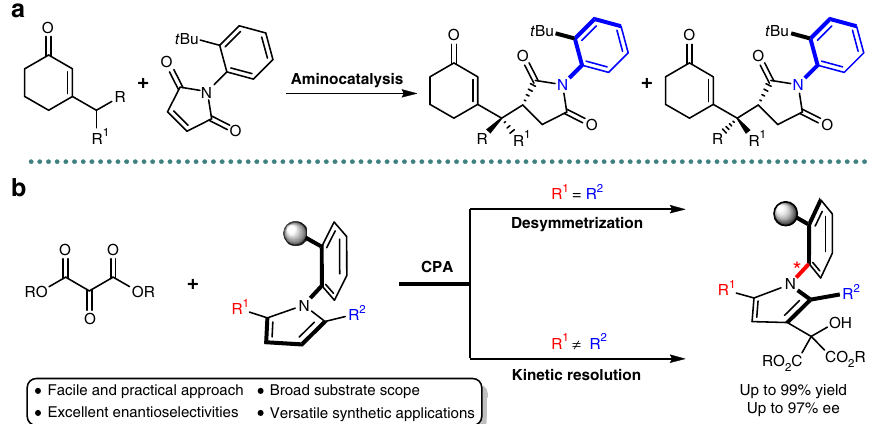
Fig. 2 Background and project synopsis. a Aminocatalytic enantioselective synthesis of atropisomeric succinimides via remote control strategy (Bencivenni ’ s work). b Our strategy for the remote enantiocontrol of axially chiral arylpyrroles. Black circle, sterically bulky substituent